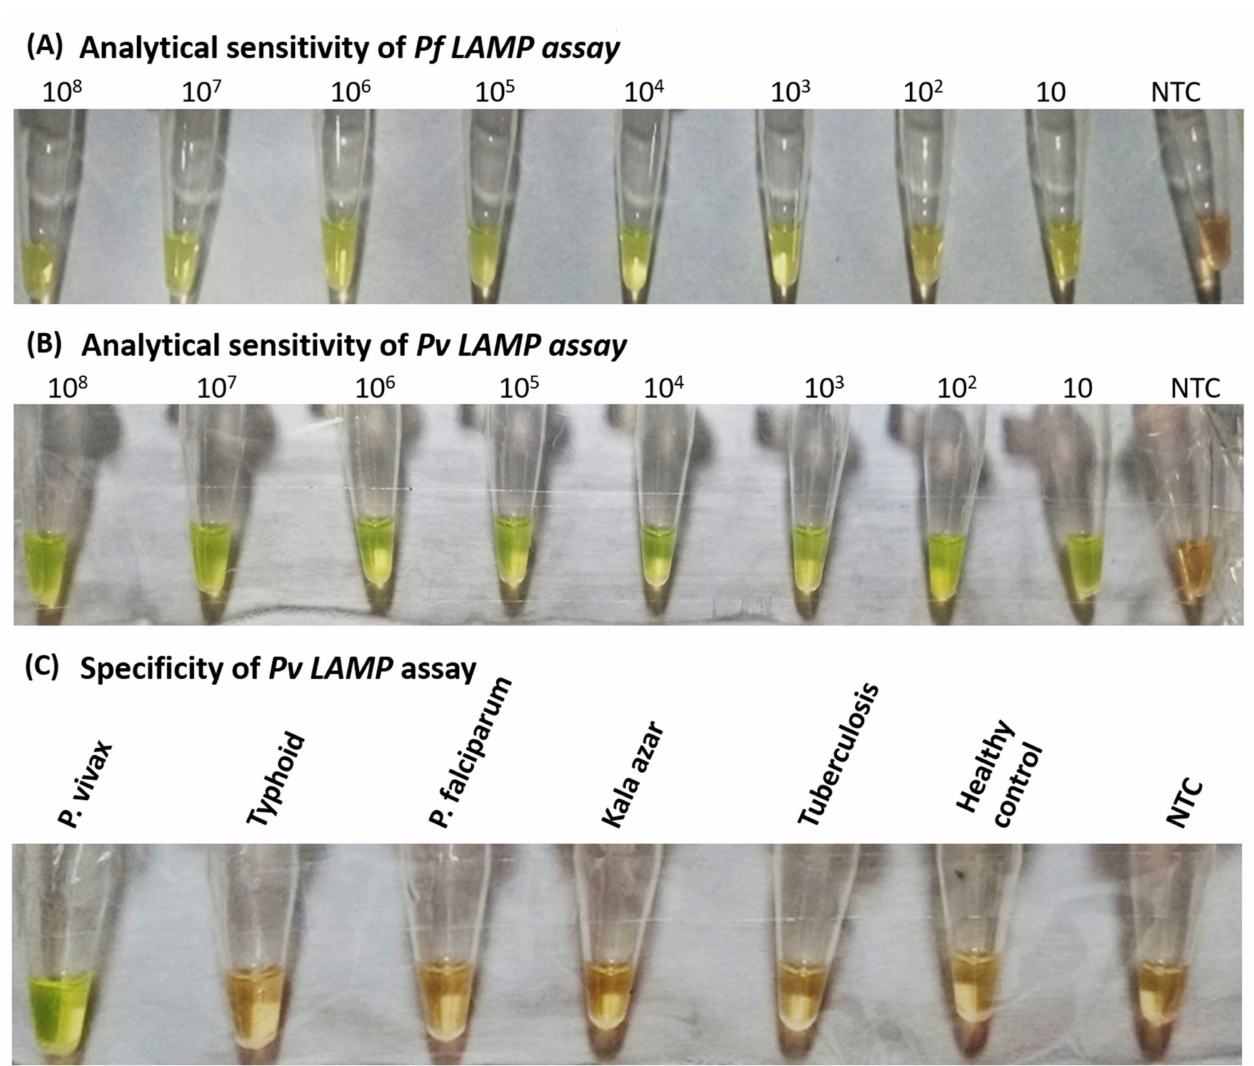
Figure 1. Analytical sensitivity and specificity analysis of SYBR™ Green I based two-tube LAMP assay: ( A ) LAMP assay performed with DNA template as 10-fold serial dilution of plasmid containing 18S rRNA sequence of P. falciparum . ( B ) LAMP assay performed with DNA template as 10-fold serial dilution of plasmid containing CRS region of P. vivax . ( C ) Pv LAMP assay performed with non-malaria-infected patient samples as DNA template for analyzing the specificity of primers specific for P. vivax . NTC-negative test